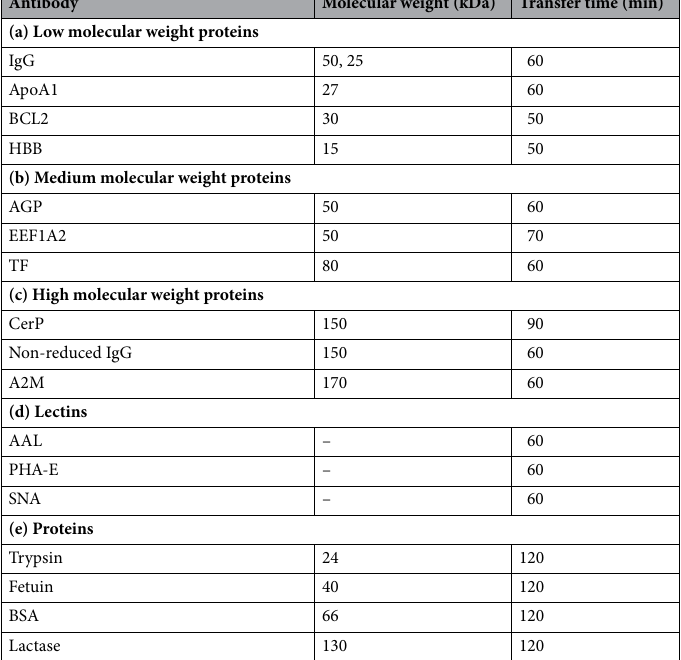
Table 2. Antibodies, lectins and proteins, as well as their molecular weights, transfer time and incubate